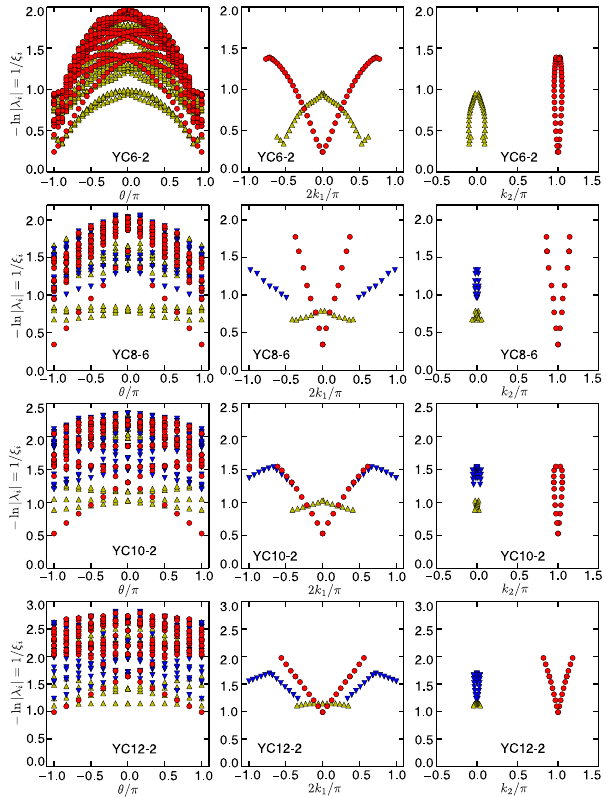
FIG. 10. The S z ¼ 1 transfer matrix spectrum of J 2 ¼ 0 . 05 for the YC6-2, YC8-6, YC10-2, and YC12-2 cylinders. Here, the bond dimension is m ¼ 6000